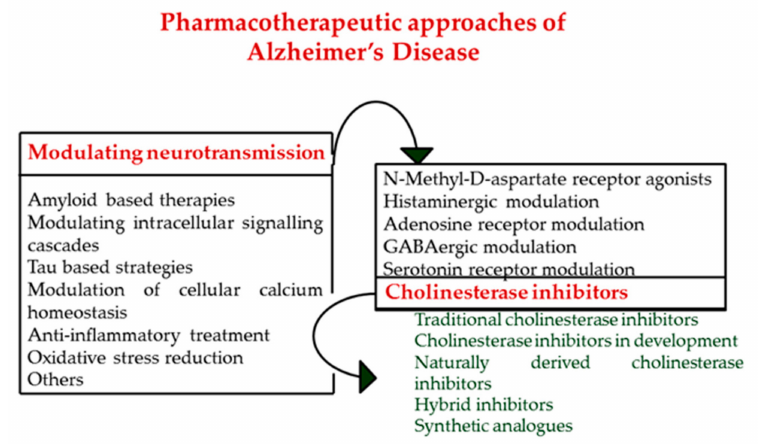
Figure 2. Schematic diagram of pharmacological approaches of Alzheimer’s disease therapies in relation to the main pathogenic mechanisms including cholinergic neuronal degeneration, the amyloid cascade hypothesis, imperfect insulin signalling, τ protein phosphorylation, calcium theory, neuroinflammation, oxidative stress, or others (dysregulation of iron metabolism, reduced glucose utilization, abnormal cholesterol homeostasis, and mitochondrial dysfunction).